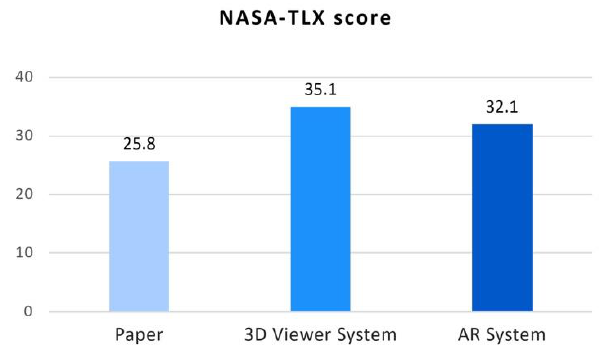
Figure 14. Average NASA-TLX scores of the three forms.